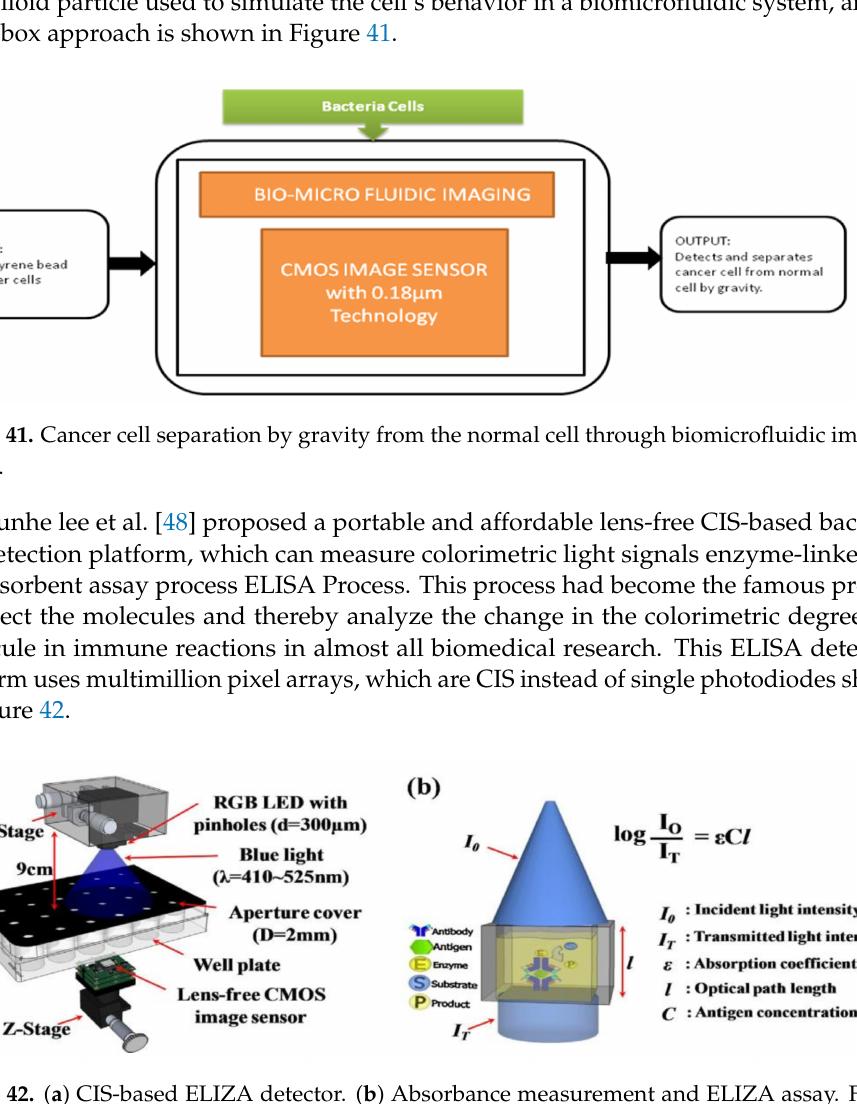
Figure 42. ( a ) CIS-based ELIZA detector. ( b ) Absorbance measurement and ELIZA assay. Figure adapted with permission from [48], Elsevier,